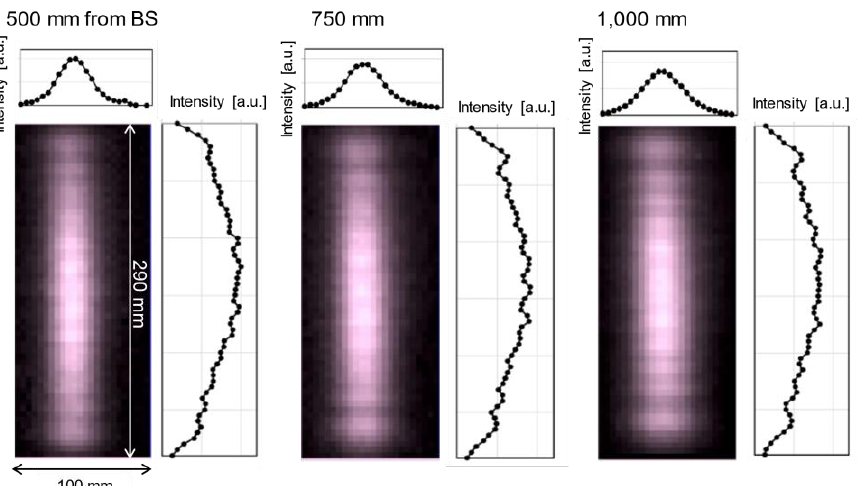
Figure 11. The illuminated beam profiles measured at 500 mm, 750 mm, and 1000 mm apart from the beam splitter.